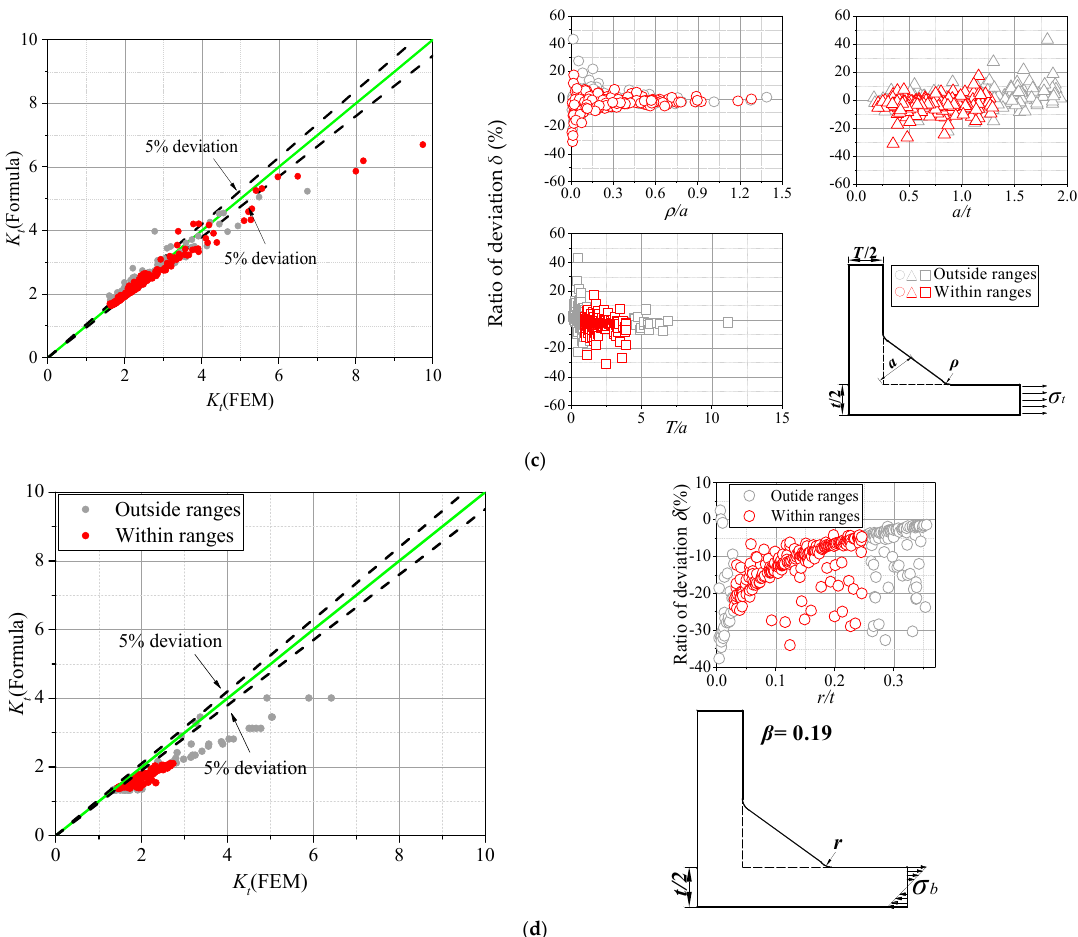
Figure 5. Accuracy of existing formulae: ( a ) Brennan et al. [17]; ( b ) Monahan [28]; ( c ) Molski et al. [24]; ( d ) Lawrence et al. [29].